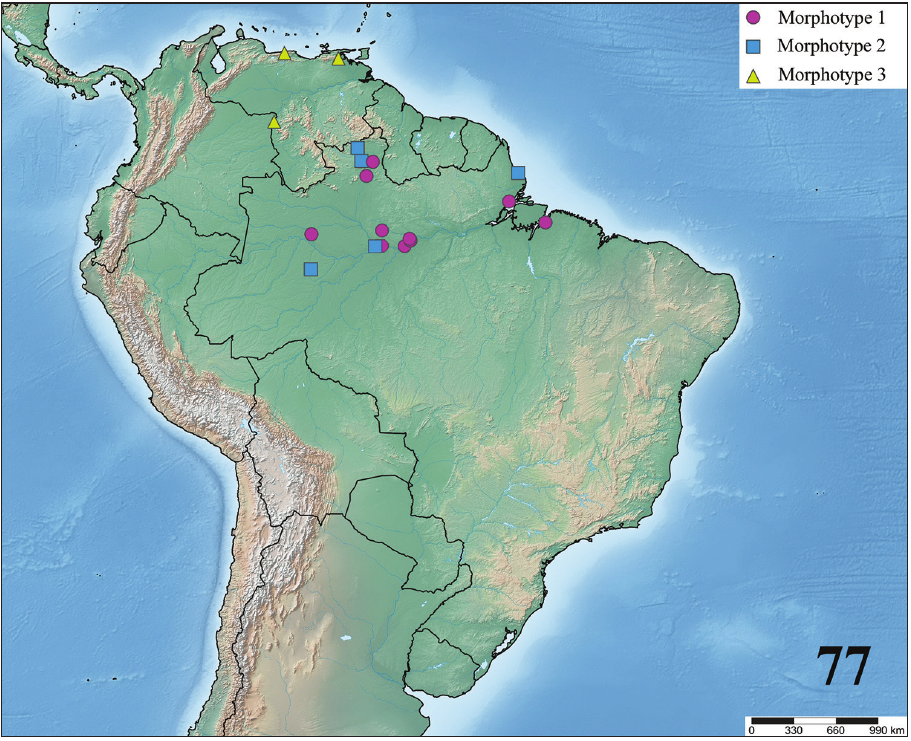
Figures 77. Map showing records of Avicularia variegata F. O. Pickard-Cambridge, 1896 stat. n.